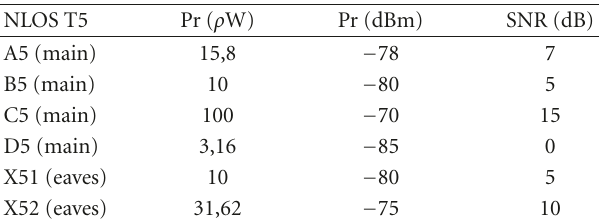
Table 5: Average received power and SNR for NLOS (T5) scheme.